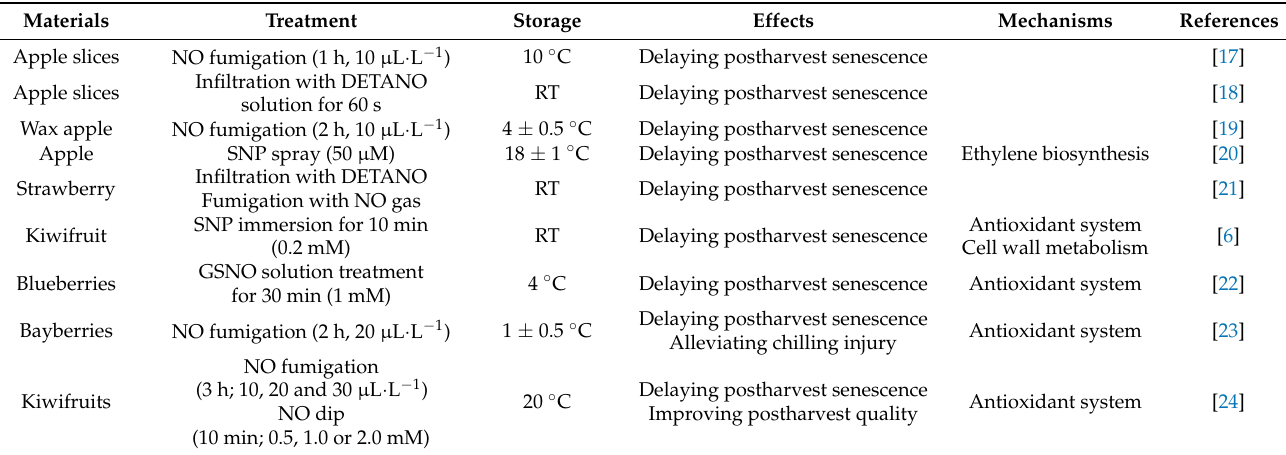
Table 1. The effects of NO on postharvest senescence in